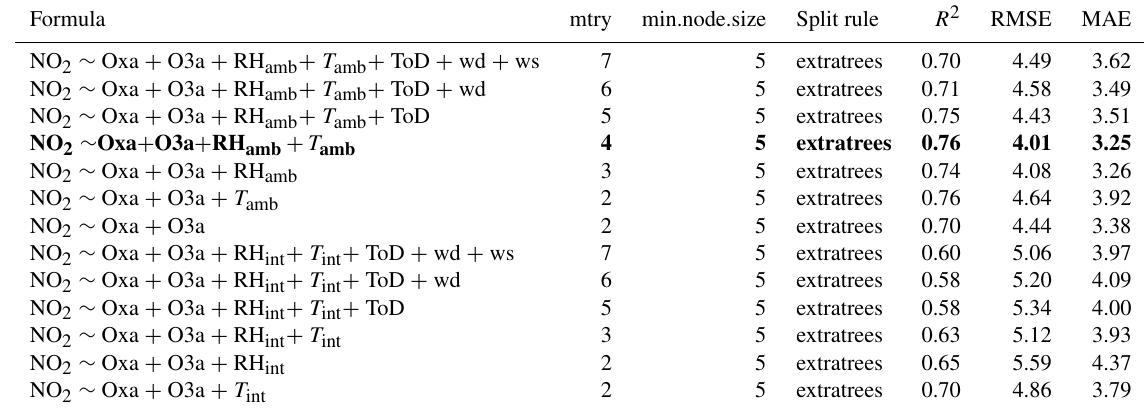
Table 4. Results of the RF model selection process for NO 2 . Min.node.size and split rule were optimized in a previous step not shown here for brevity and are therefore constant. The most accurate model is in bold. RMSE and MAE are in units of parts per billion. Formula